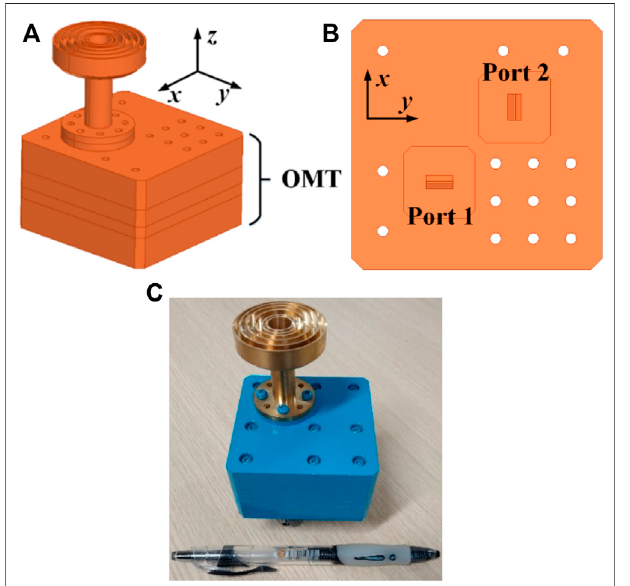
FIGURE 8 | Photographs of (A) Co-simulation model of the OMT and hornantenna. (B) Bottom viewoftheOMT. (C) Fabricated dualpolarized horn antenna with OMT.